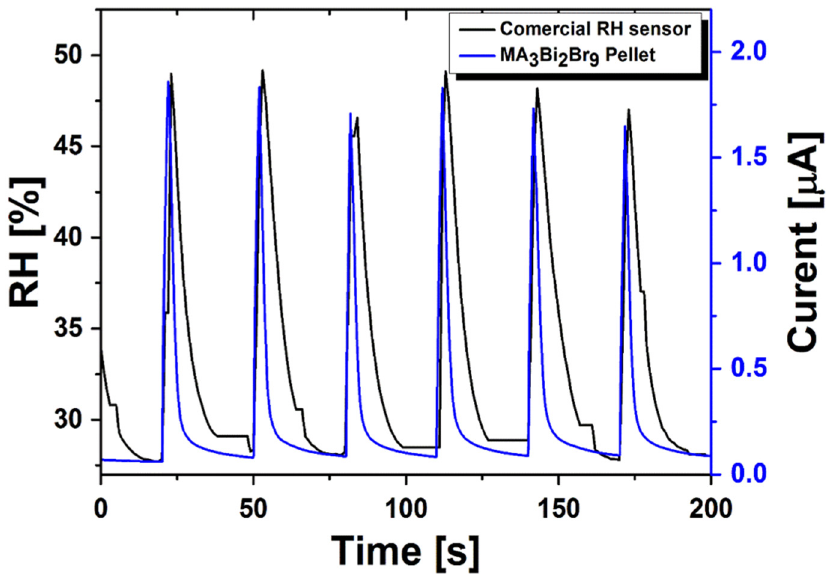
Figure 4. Ambient temperature responsivity of powder pellets over time in comparison to the commercial sensor from RH ~25–50%. The signals were scaled to normal.